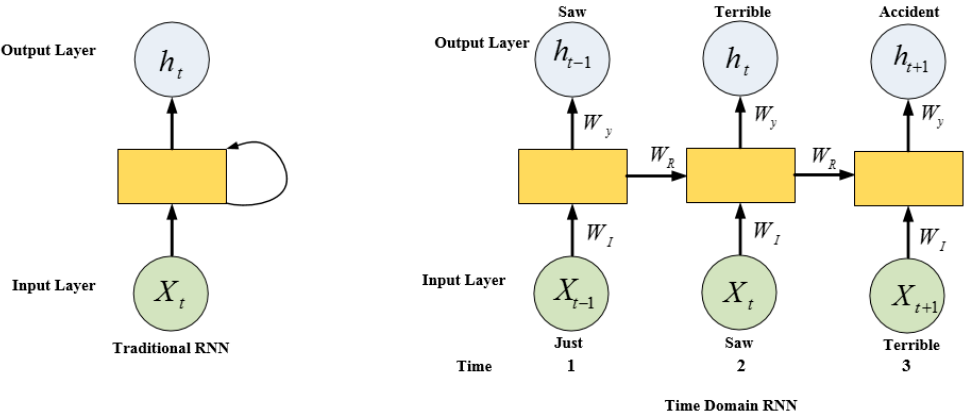
Figure 5. Traditional RNN and time domain RNN.